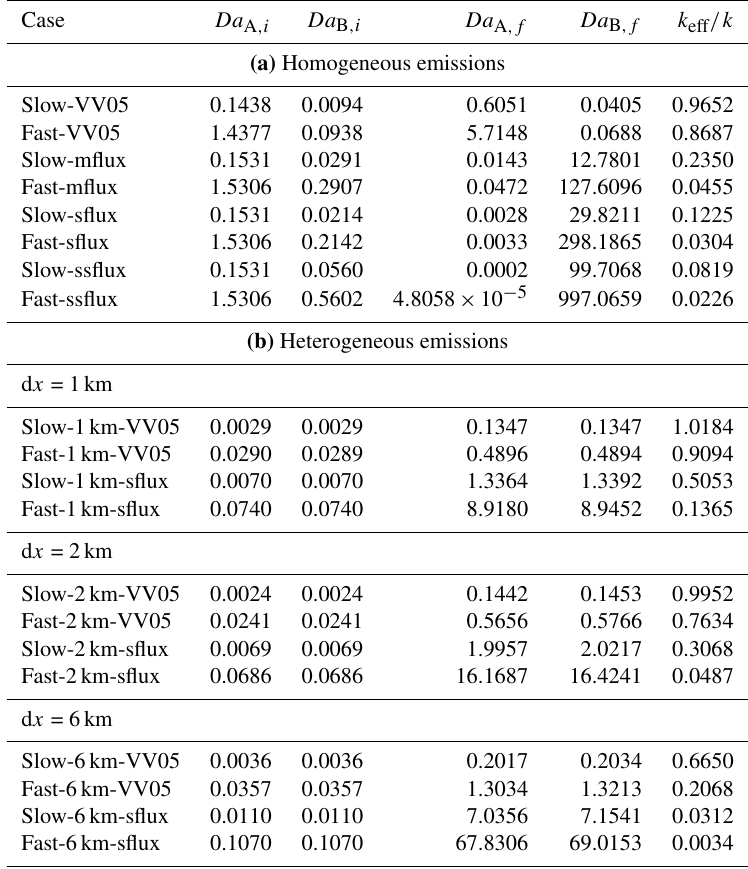
Table 2. The initial Damköhler numbers Da A ,i and Da B ,i , and final Damköhler numbers Da A ,f and Da B ,f with the resultant